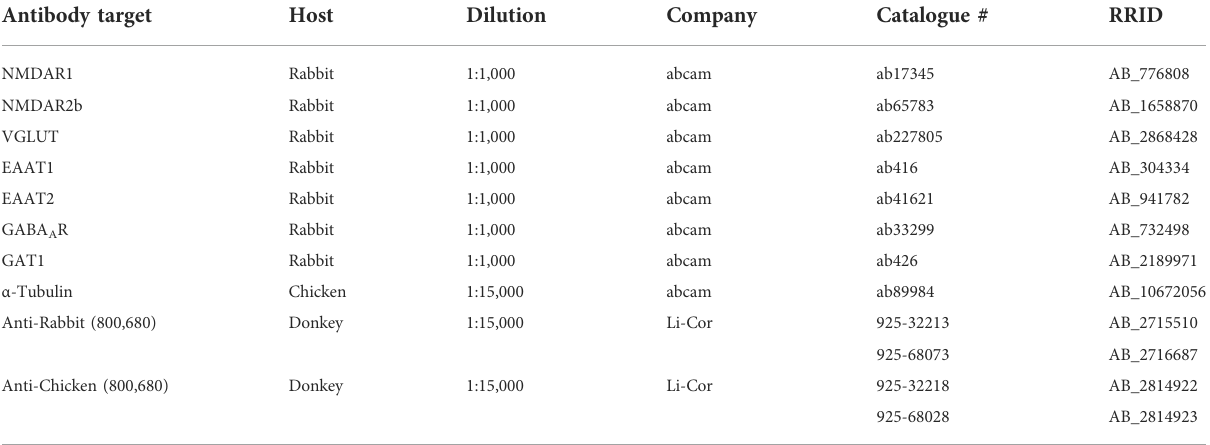
TABLE 1 List of primary and secondary antibodies used for Western blot analysis. Antibody